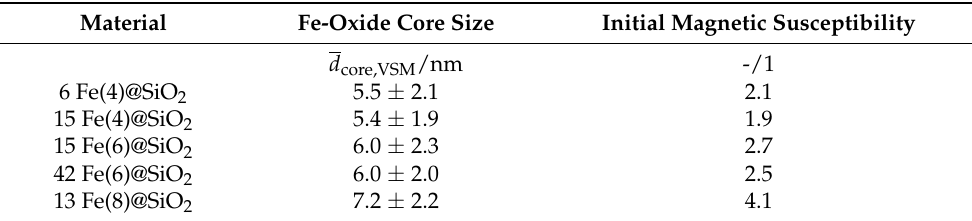
Figure 4. ( A ) Example for the M - H curve of as-made 13Fe(8)@SiO 2 core-shell particles measured by VSM (open diamonds) together with fitted curve (red line) calculated via superposition of Langevin functions. ( B ) Core size distributions of two selected as-made Fe@SiO 2 core-shell particles (black: 15Fe(4)@SiO 2 , red: 13Fe(8)@SiO 2 ) fitted from corresponding M - H curves with a superposition of Langevin functions. Table 4. Average core size and initial magnetic susceptibility fitted from the M - H curve with a superposition of Langevin